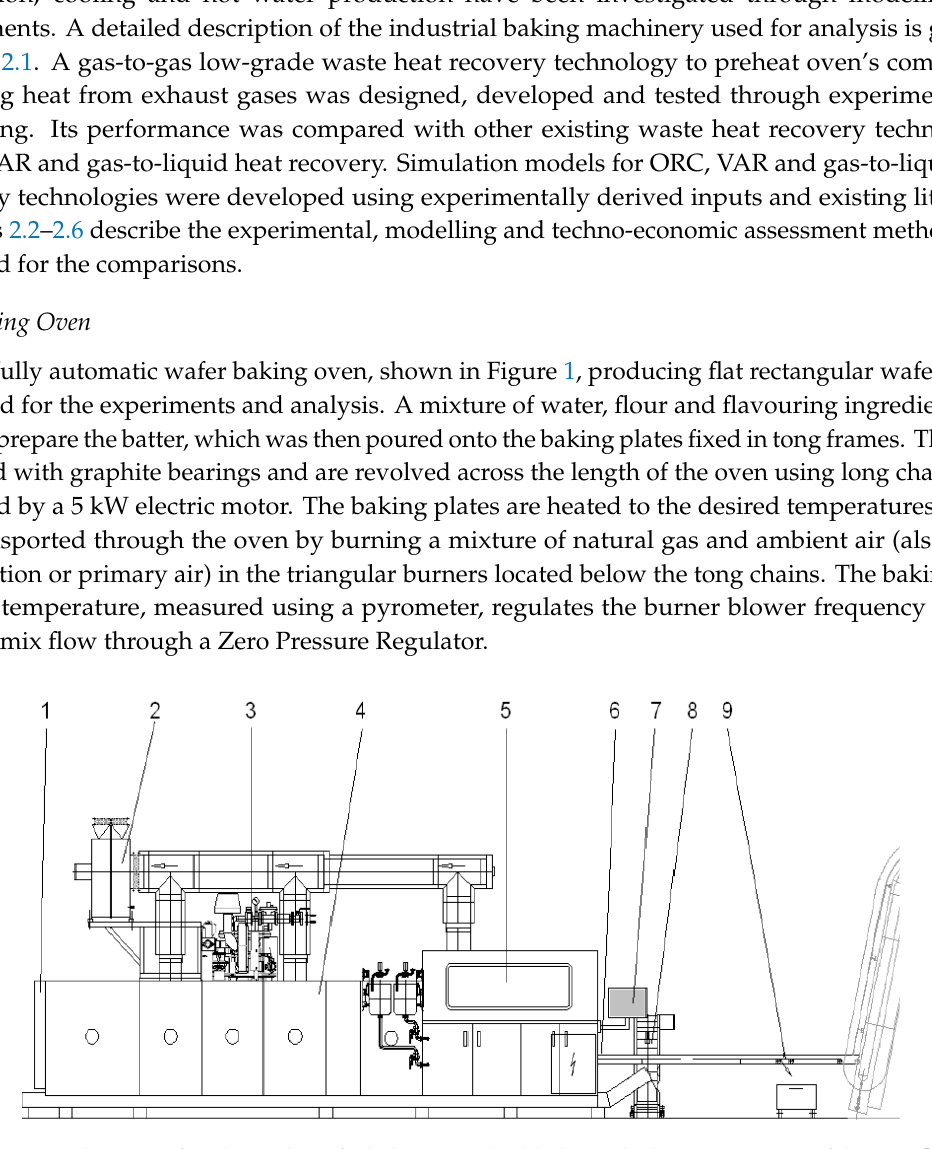
Figure 1. Schematic of a pilot-scale wafer baking oven highlighting the key components of the oven